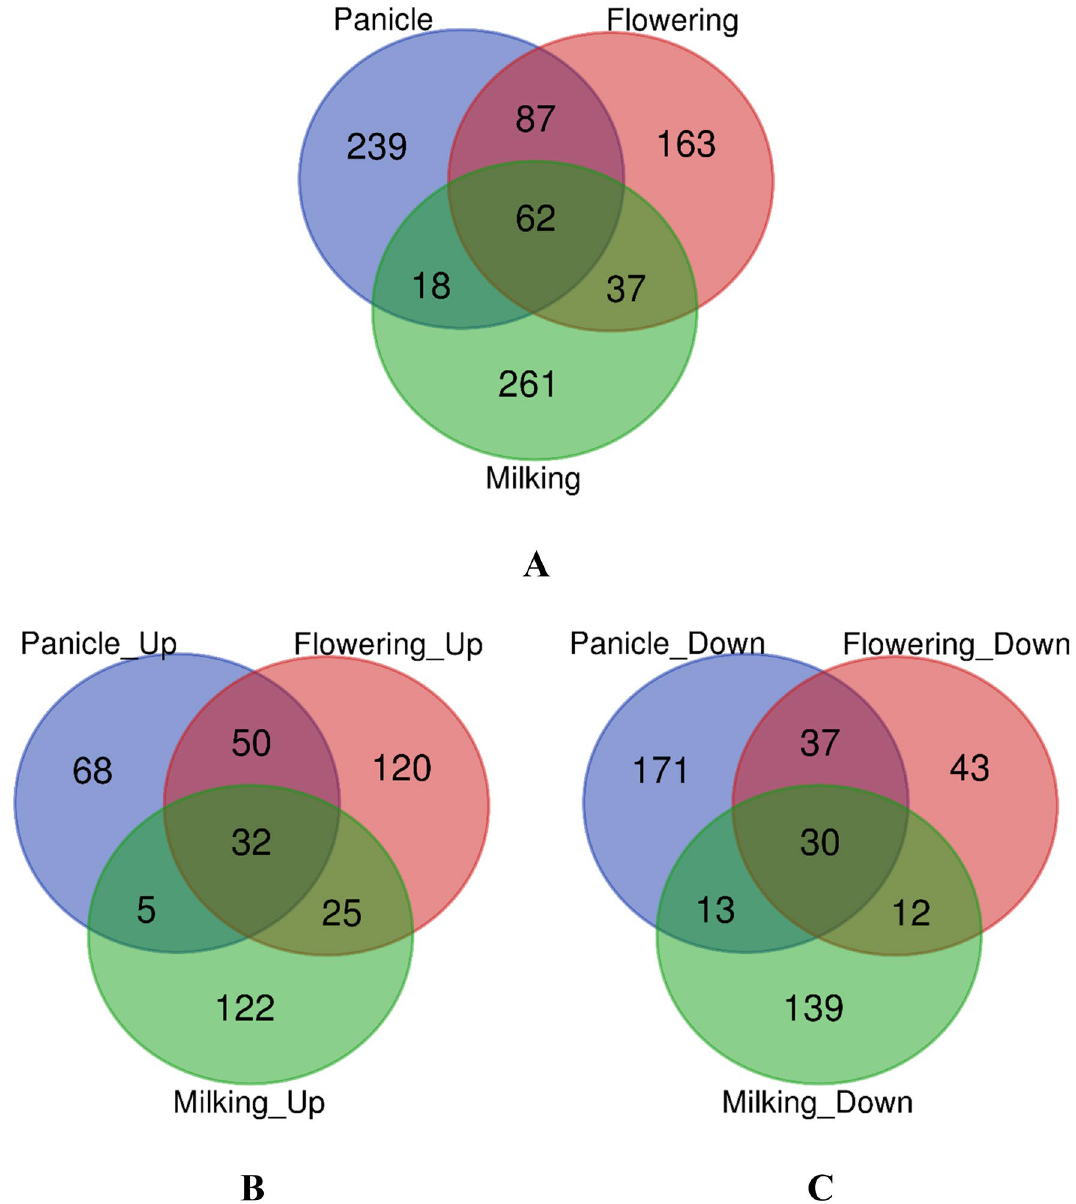
Figure 1. Characterization of Differentially Expressed Genes (DEGs) in pearl millet genotypes during different stages of panicle developmental i.e. Panicle initiation, Flowering and Milking. ( A ) Over-all distribution of differentially expressed genes during different stage, ( B ) Distribution of up-regulated genes among the different stage of panicle development and ( C ) Distribution of down-regulated genes among the different stage of panicle